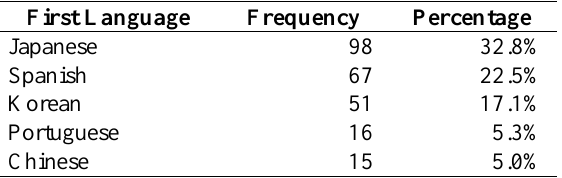
Native Language of Participants Length of Stay in the